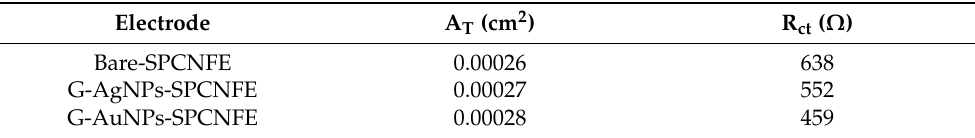
Table 1. Electroactive area (A T ) calculated using the Randles-Sevcik equation, and charge transfer resistance (R ct ) values obtained by fitting the Nyquist diagram data for every studied electrode to a Randles